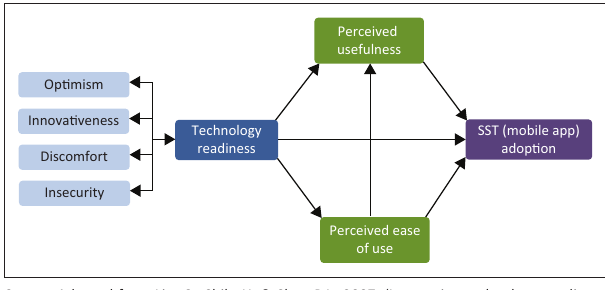
FIGURE 1: The influence of technology readiness and perceptions regarding mobile application